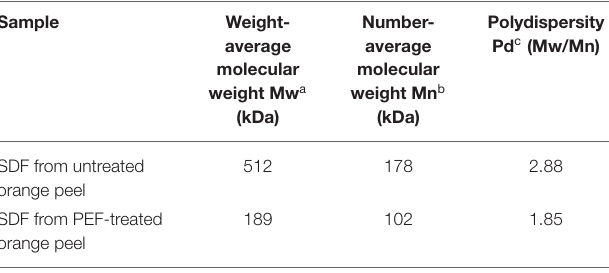
TABLE 4 | Effects of PEF A on the molecular weight of orange peel